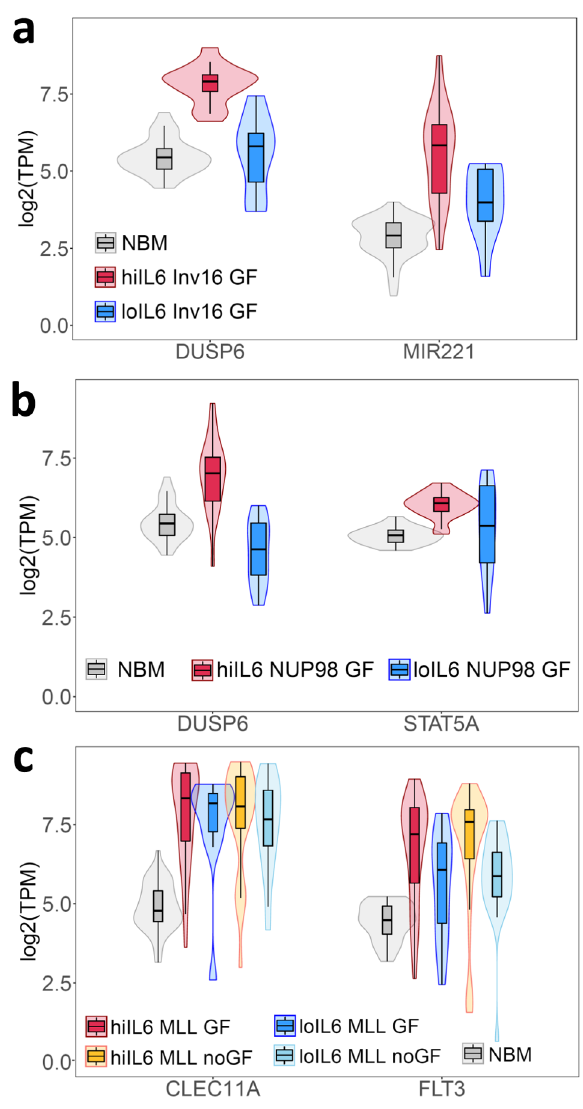
Fig. 5 | Selected differentially upregulated genes in high-IL6/R pAML samples. a Samples with RAS/FLT3 point mutations and co-occurring Inv(16). b Samples with NUP98 translocations and RAS/FTL3 point mutations. c Samples carrying ML-rearrangements with or without mutations in the growth factor signaling associated genes FLT3 and RAS ( “ indicated as “ GF ” and “ noGF ” respectively). For all 3 panels, all within-group pairwise two-sided comparison Mann – Whitney U Test P values are <0.05. The abbreviations “ hiIL6 ” and “ loIL6 ” indicate the high- IL6/R and low-IL6/R pAML subtypes. Numbers of samples per group: NBM=45, low-IL6/R=306, hiIL6 Inv16 GF=17, loIL6 Inv16 GF=11, hiIL6 NUP98 GF=20, loIL6 NUP98 GF=12, hiIL6 MLL GF=53, loIL6 MLL GF=13, hiIL6 MLL noGF = 46, loIL6 MLLnoGF= 24. Boxplotsshowthemedianand the upperandlowercentral- quartiles. The expected range of the data is indicated by